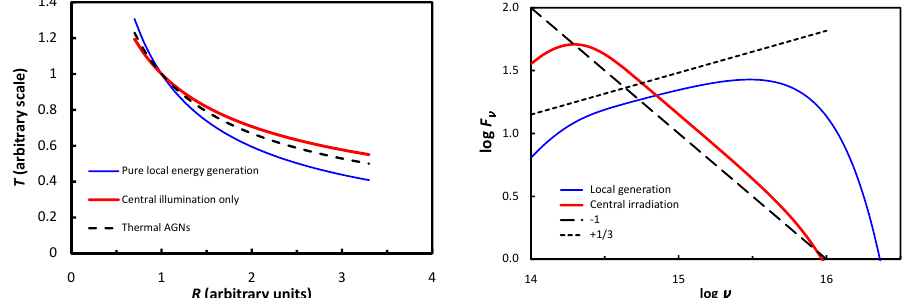
Fig. 4. Panel (a). The temperature gradients in an accretion flow corresponding to purely local energy generation (the case considered by Pringle & Rees 1972 and Shakura & Sunyaev 1973) and to central irradiation only. The dashed line shows the temperature structure deduced from the observed spectral energy distribution of an AGN (Gaskell 2008 for details). Panel (b). The spectra produced by truncated disks with the theoretical temperature structures shown in the left panel. The dotted line shows the classic F (cid:23) / (cid:23) +1 = 3 accretion disk spectrum of PRSS for reference and the dashed line shows a F (cid:23) / (cid:23) − 1